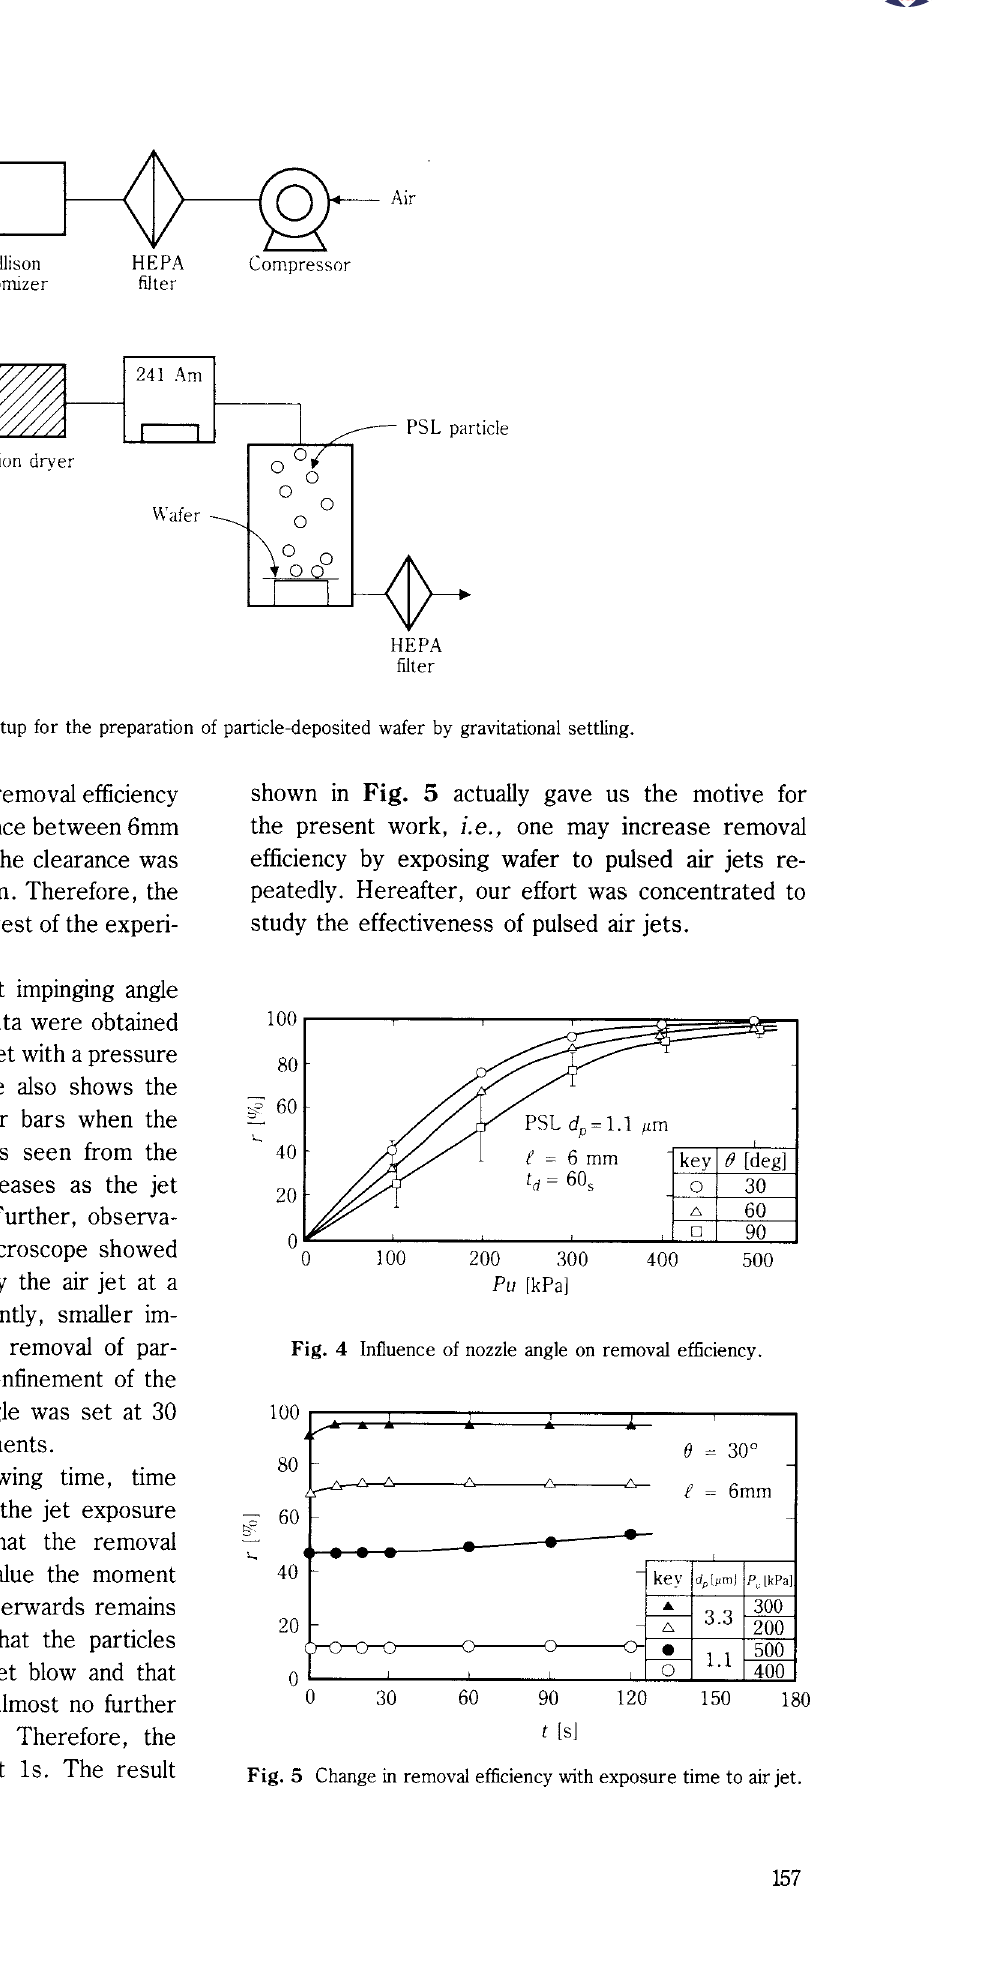
Fig. 5 Change in removal efficiency with exposure time to air